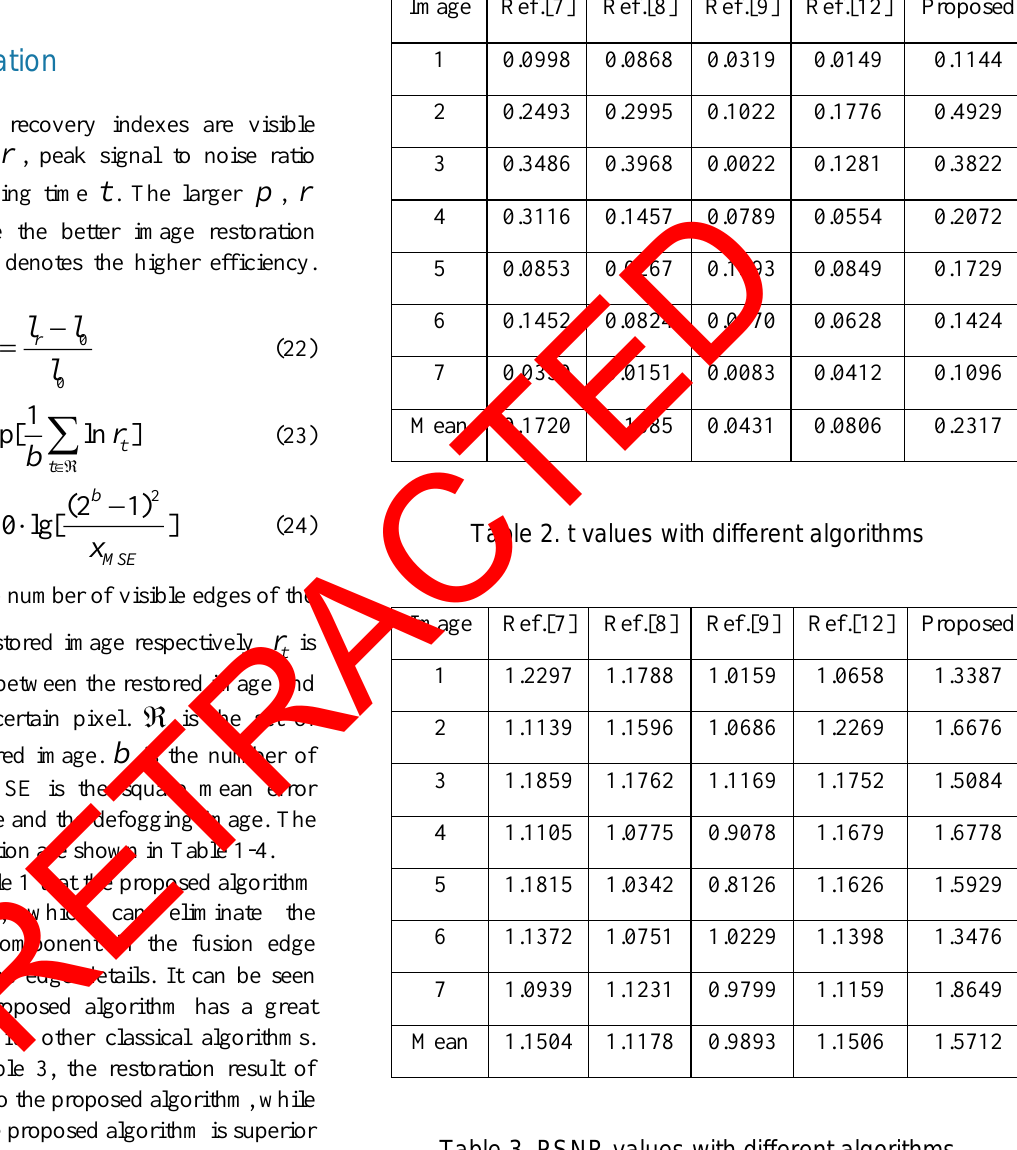
Table 3. PSNR values with different